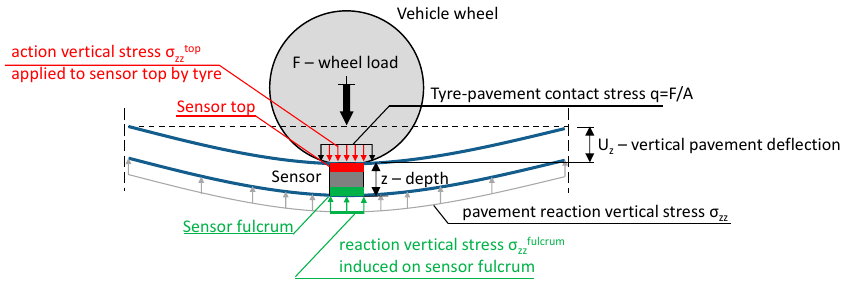
Figure 5. Scheme of stress effects on the WIM sensor installed inside the pavement structure.